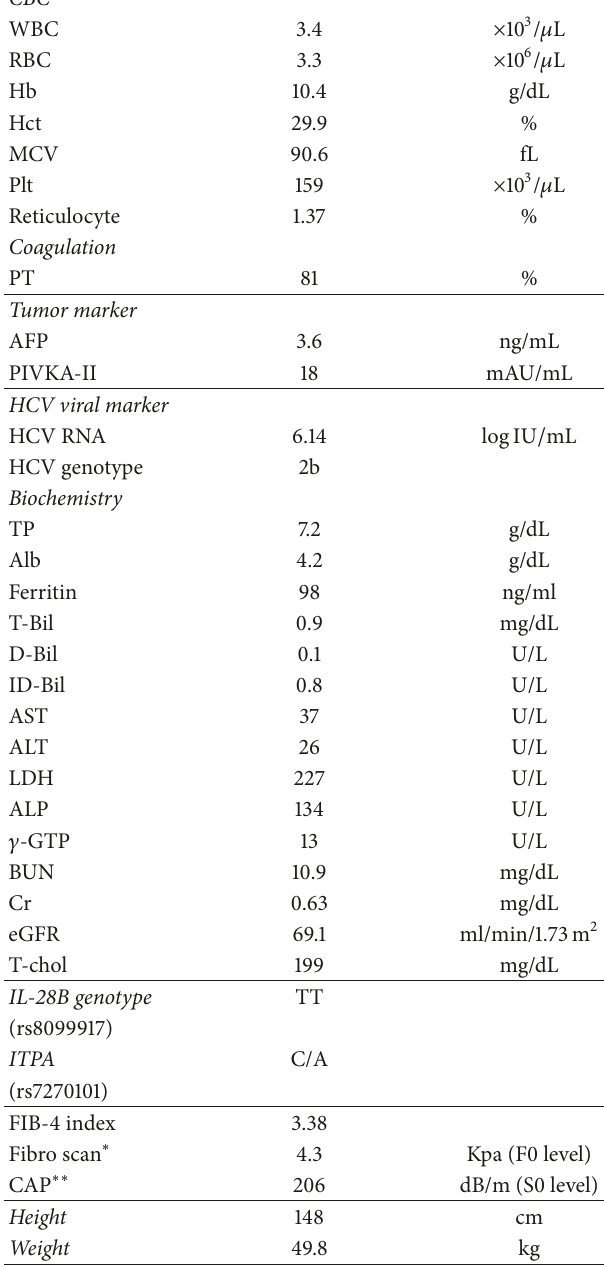
Table 1: Laboratory results at the start of SOF/RBV combination therapy